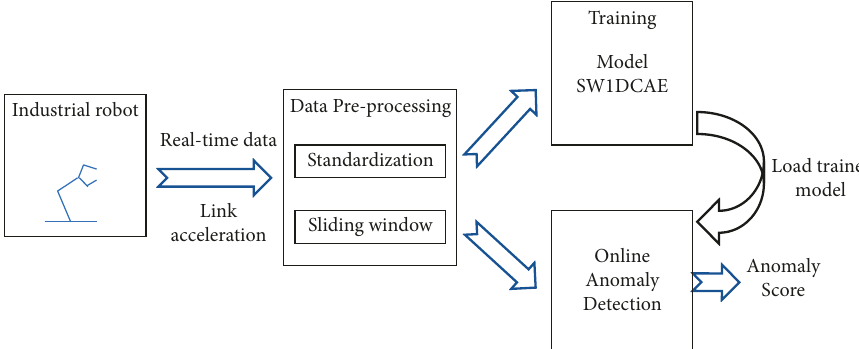
Figure 7: Vibration anomaly detection process.